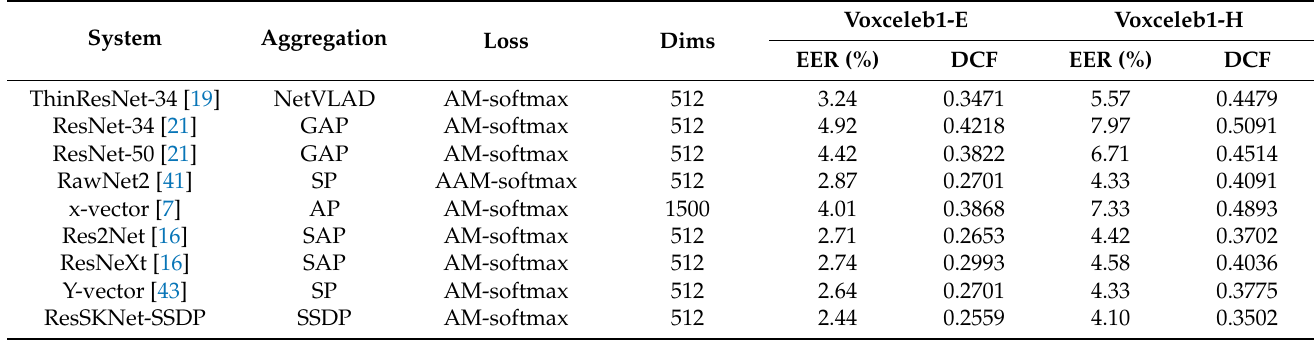
Table 7. Results of different systems on the Voxceleb1-E and Voxceleb1-H test